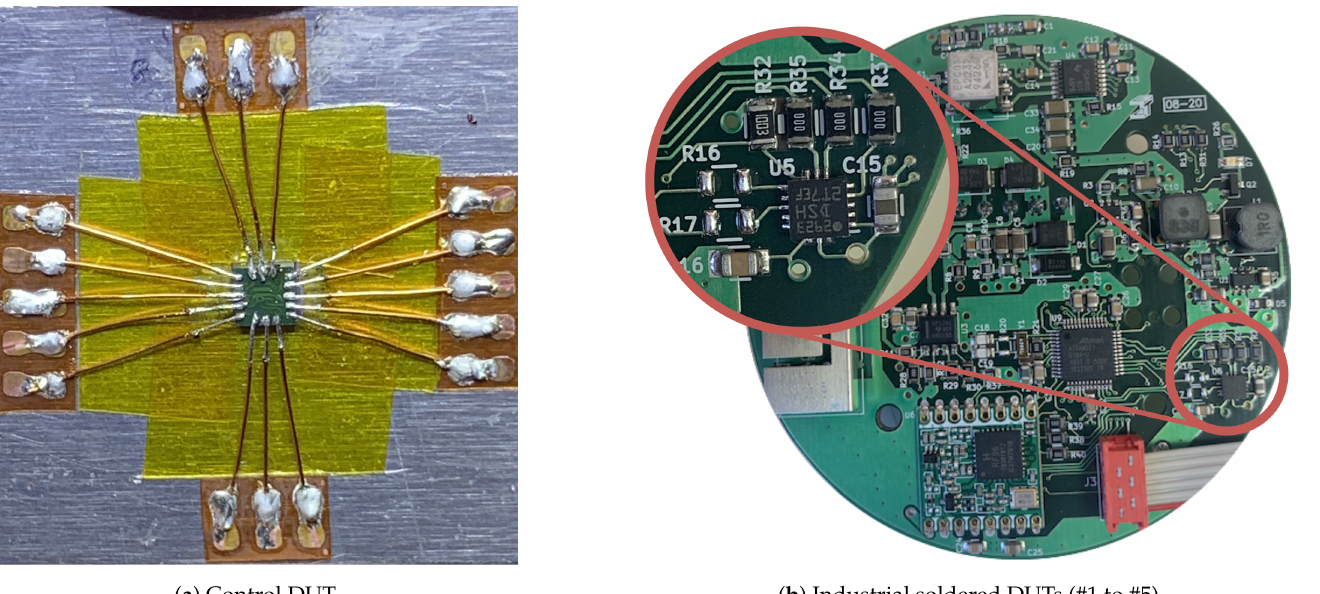
Figure 4. DUTs used during